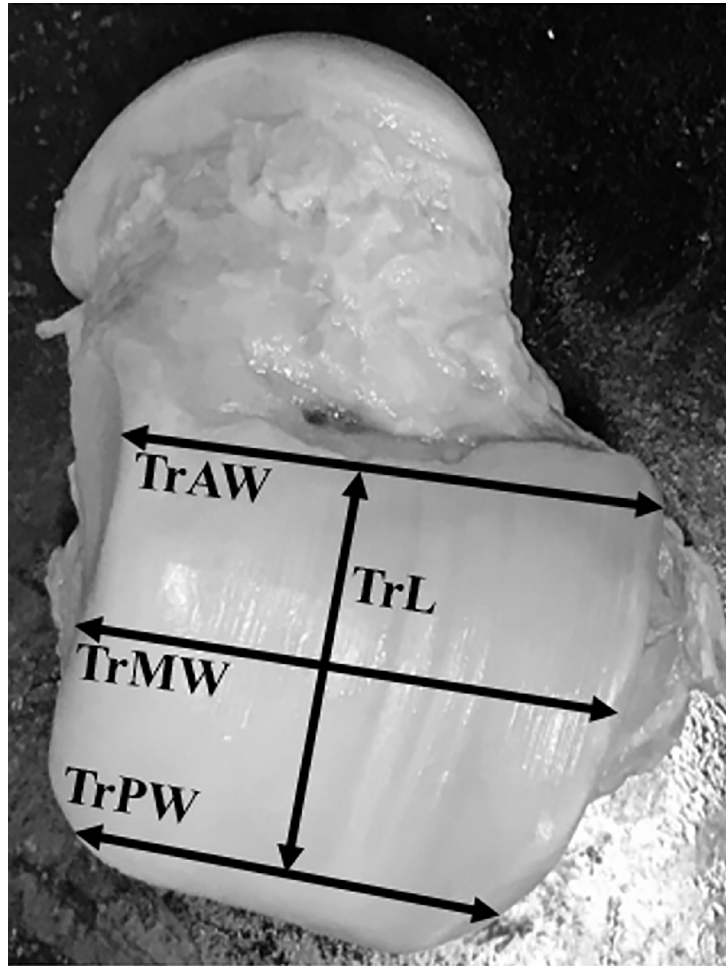
Fig 1. Abbreviations: Talar length (TaL); Anterior trochlear width (TrAW); Middle trochlear width (TrMW); Posterior trochlear width (TrPW); Trochlear length